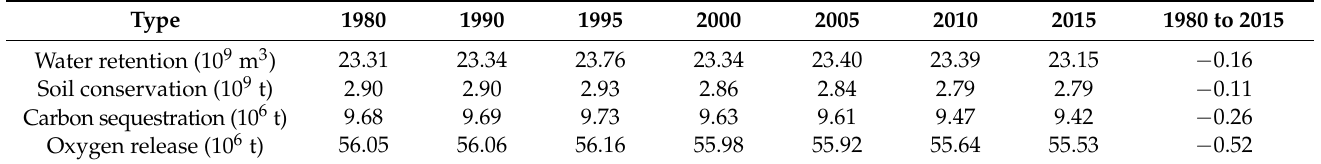
Figure 5. Time series heatmap of ecosystem services on Hainan Island from 1980 to 2015. ( a ) Time series heatmap of carbon sequestration on Hainan Island from 1980 to 2015. ( b ) Time series heatmap of oxygen release on Hainan Island from 1980 to 2015. ( c ) Time series heatmap of water retention on Hainan Island from 1980 to 2015. ( d ) Time series heatmap of soil conservation on Hainan Island from 1980 to 2015. Table 2. Changes in the physical quantities of ecosystem services on Hainan Island from 1980 to